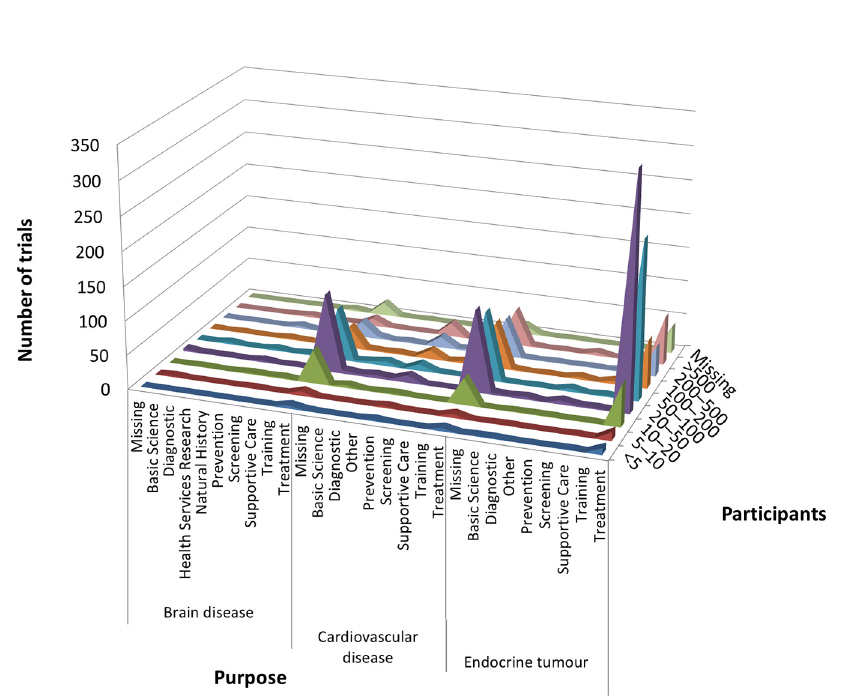
Fig 2. Cross-analyses between trial purpose and participants in ClinicalTrials.gov. Curve areas represent the number of trials across the participants and the trial purposes, for brain diseases, cardiovascular disease, and endocrine tumor,